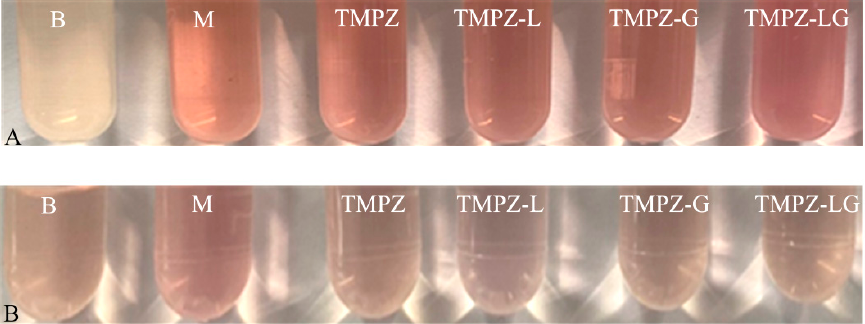
Figure 8. Color reaction diagram of MDA with TBA. ( A ) MDA in liver homogenate reacted with TBA; ( B ) MDA in low density lipoprotein reacted with TBA (where “B” is blank control group; “M” is model